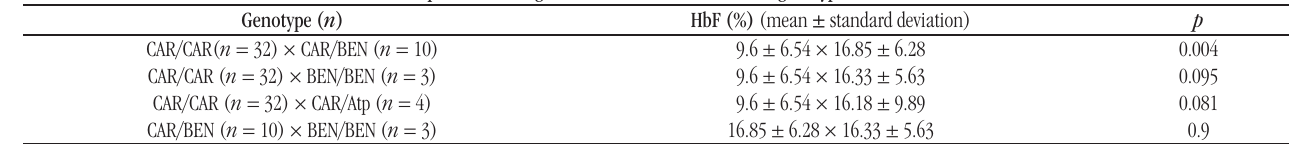
taBLE 4 − Comparison among HbF values in the different SS genotypes in the state of Paraná